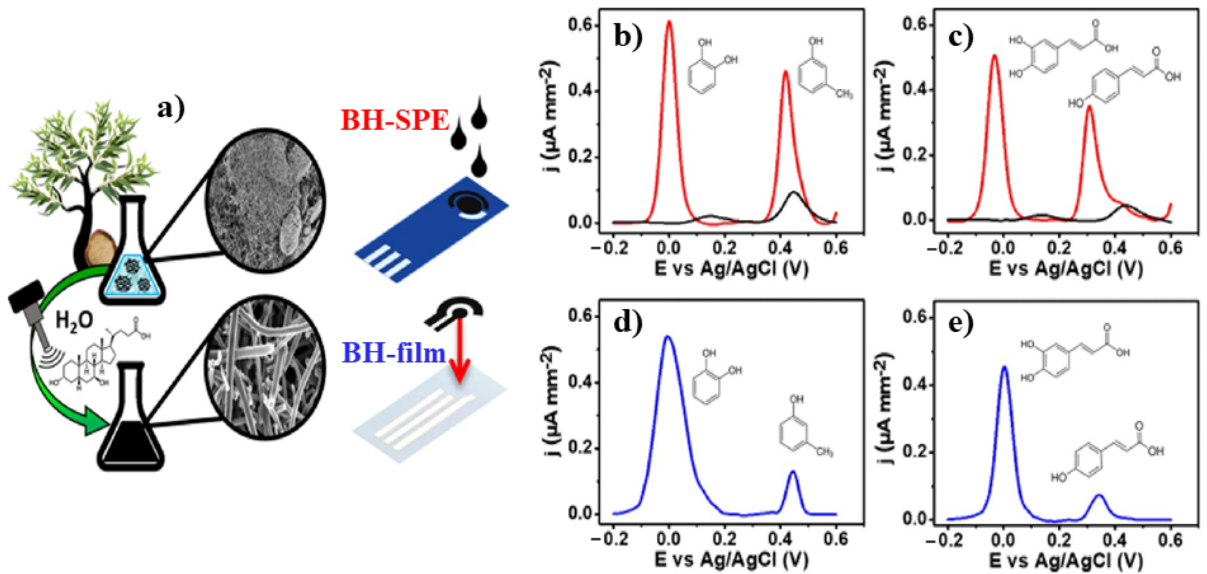
3), sensitivity for hydroxytyrosol (LOD ≤ 0.6 μ M) and tyrosol (LOD ≤ 3.8 μ M) and recovery in the real sample matrix (91–111%, RSD ≤ 6%; n = 3) [134]. Figure 8. ( a ) Schematic representation of BH ‐ SPE (red lines) and BH ‐ film (blue lines) preparation Figure 8. ( a ) Schematic representation of BH-SPE (red lines) and BH-film (blue lines) preparation and and ( b – e ) their application in the detection of caffeic acid and dopamine (25 μ M). ( b – e ) their application in the detection of caffeic acid and dopamine (25 µ However, there are different works in which biochar is exploited for the development of powerful humidity sensors. Among them, one of the most promising is that of Jagdale et al. (2019) [135]. They proposed biochar from waste coffee as a material for the development of impedimetric humidity sensors (see Figure 9). The sensing platforms were produced (heated at 300 °C) using an ink ‐ containing CGB with polyvinyl butyral (PVB), which acts as a temporary binder and ethylene glycol monobutyral ether, as an organic vehicle. The sensitivity tests (humidity), performed at room temperature under a flow of 1.7 Lmin − 1 in a relative humidity range from 0 to 100%, showed an initial impedance of the film of 25.2 ± 0.15 M Ω , which changes to 12.3 M Ω under 98% humidity exposure, with a sensor response above 20% [135].